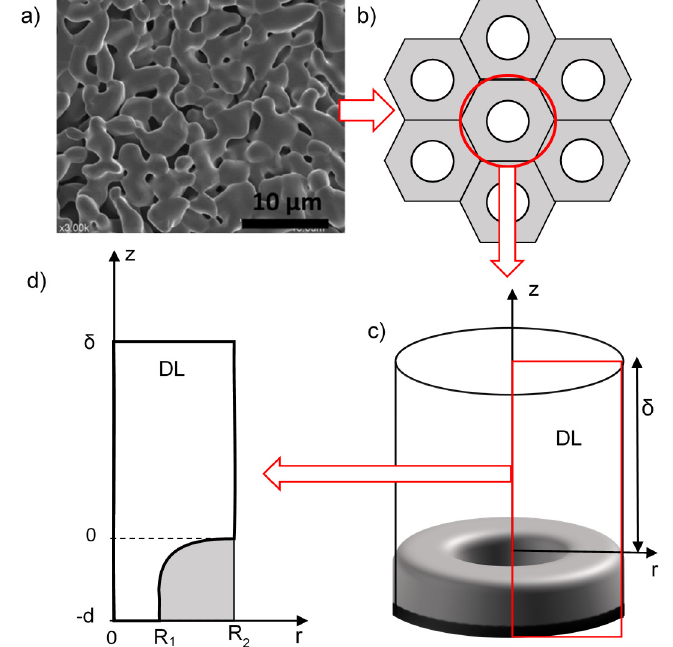
Figure 2. The schematic representation of the transition from a complex surface structure of the reactive electrochemical membranes (REM) ( a ) to the simplified uniformly distributed pattern ( b ) and three-dimensional (3D) model representation with axial symmetry ( c ) and two-dimensional (2D) unit cell ( d ).